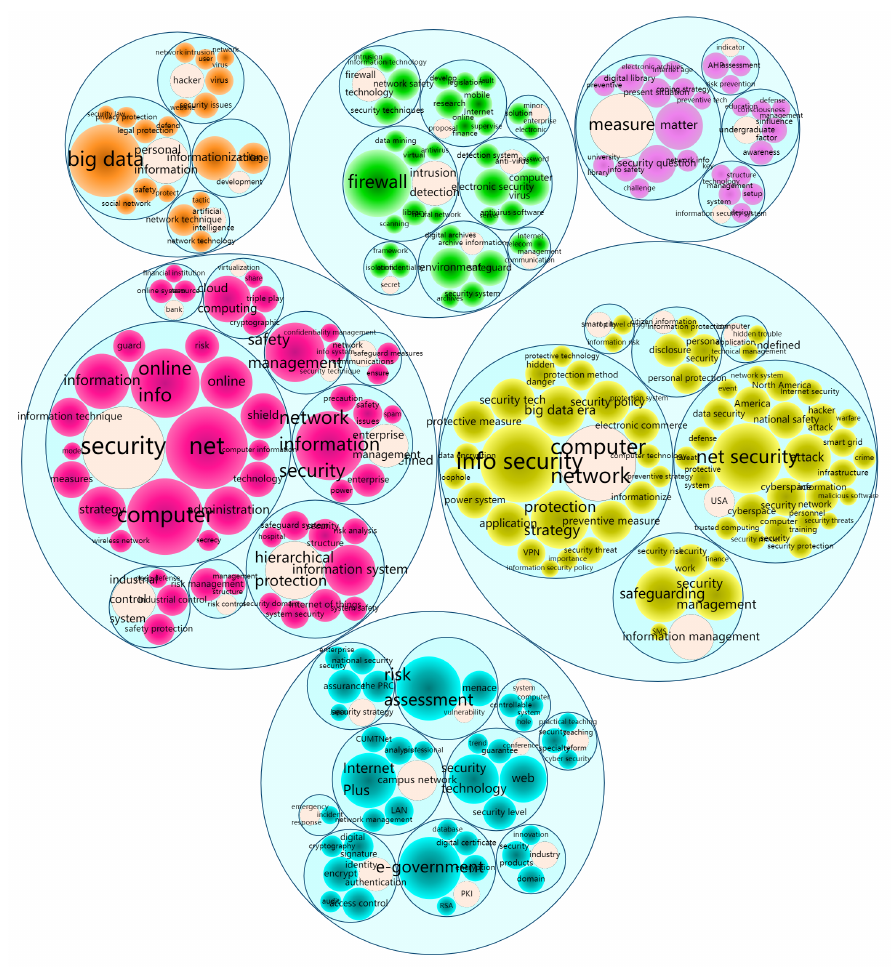
Figure 8. Clustering results of network constructed by sliding